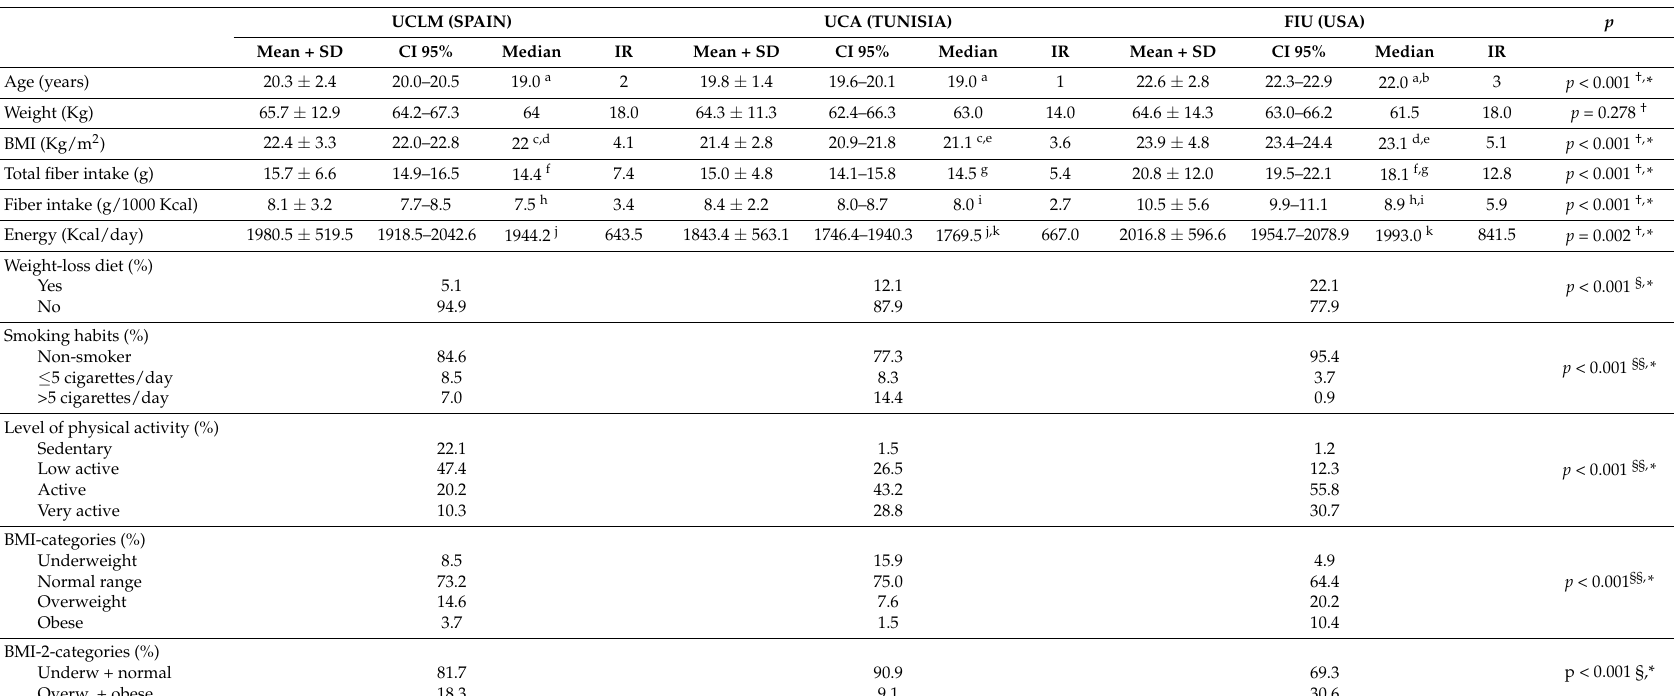
Table 3. Sociodemographic, anthropometric, and lifestyle differences among the three